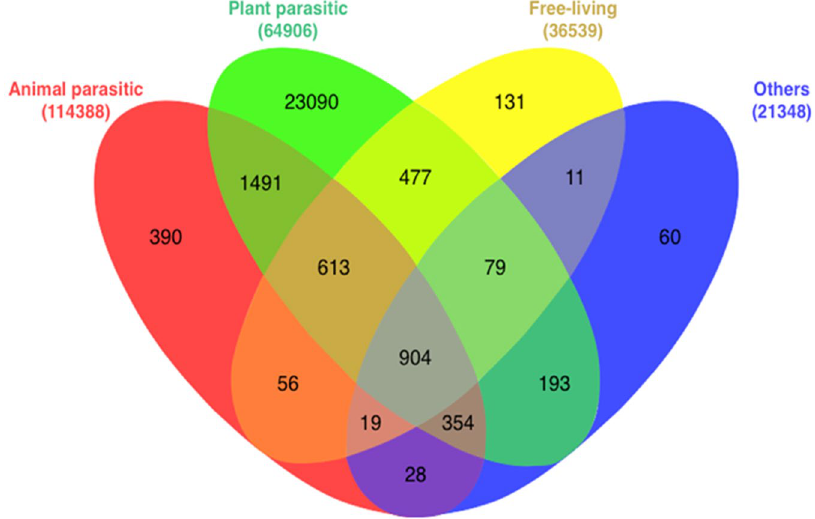
Figure 4. A Venn diagram showing the BLAST results of H. schachtii transcriptome assembly against Nembase4 ESTs database. All ESTs were categorized based on the feeding habits of their source nematode species into: animal parasitic (red), plant parasitic, (green); free-living (yellow); and others, which represent the rest of the species (blue). The numbers in parentheses represent the number of ESTs in each category and the numbers within each category represent the number of H. schachtii contigs that have a positive hit within this category (bit score >